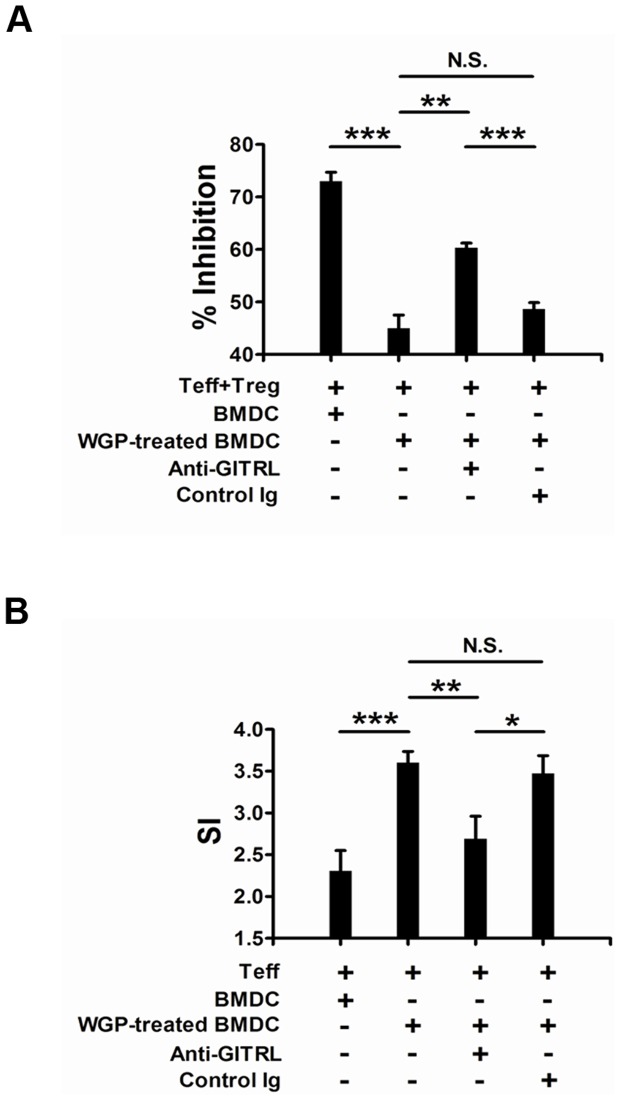
Increased GITRL expression on BMDCs by WGP impairs Treg-mediated suppressive effect and enhances Teff proliferation.Murine CD4+CD25− Teff and CD4+CD25+ Treg cells were purified from C57BL/6 mice splenocytes as described in Materials and Methods. BMDCs were stimulated with WGP (100 µg/ml) or not for 24 h. Cells were harvested, treated with mitomycin C and then co-cultured at a 1∶5 ratio with CD4+CD25− Teff and CD4+CD25+ Treg cells (A) or Teff cells (B) in the presence of anti-CD3 mAb with or without anti-GITRL blocking antibody or control Igs for 72 h, Treg and Teff cells were added at 1∶1 ratio. Wells were pulsed with 1 µCi/well [3H]-thymidine for the last 16 h. Data are expressed as means ± SD. ***P<0.001, **P<0.01, *P<0.05. N.S. represents no significance between columns.